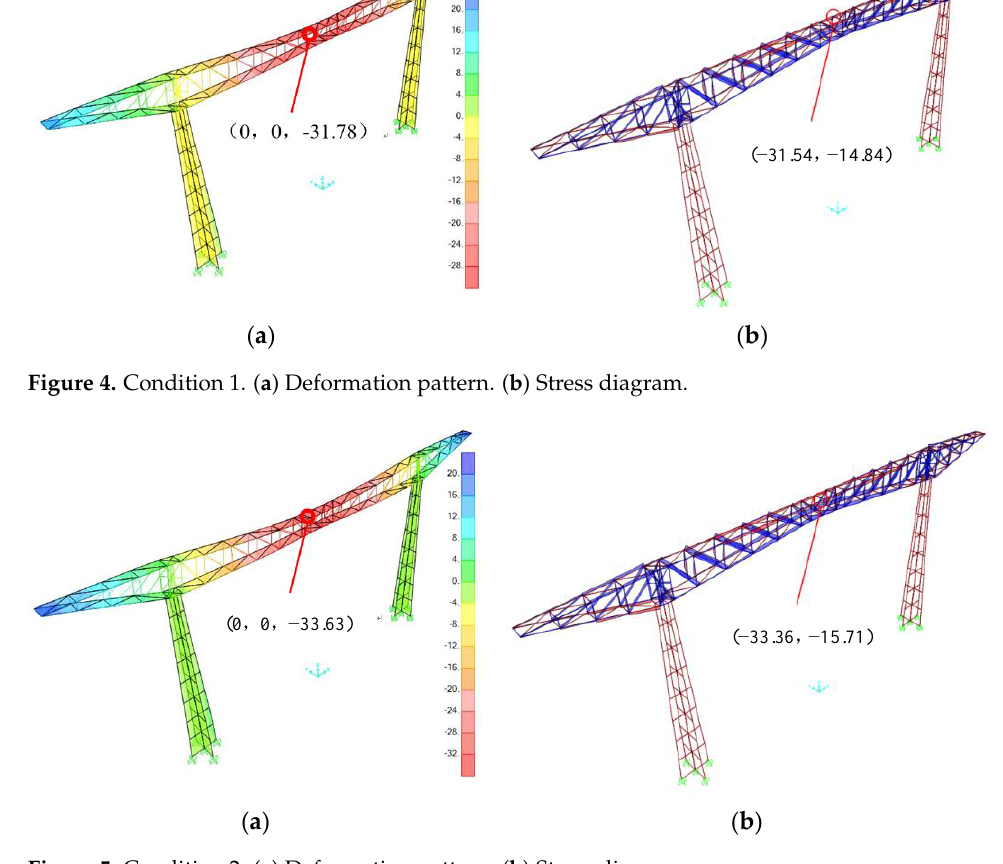
Figure 5. Condition 2. ( a ) Deformation pattern. ( b ) Stress diagram.